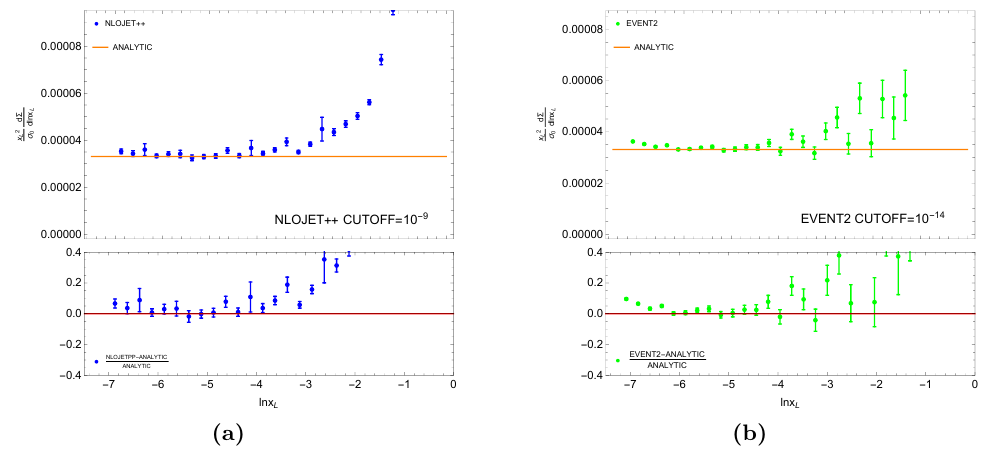
Figure 9. Analytic results for the EEEC in an equilateral triangle con(cid:12)guration in the collinear limit, compared with numerical results from NLOJET++ in (a) and Event2 in (b), with Q = m Z . Excellent agreement is observed as x L !